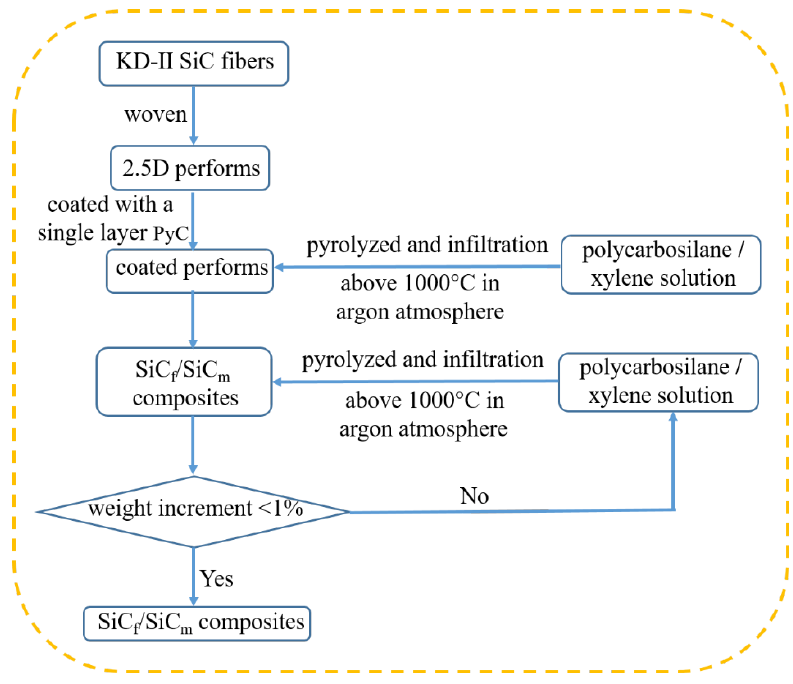
Figure 1. Fabrication flowchart of the composite.